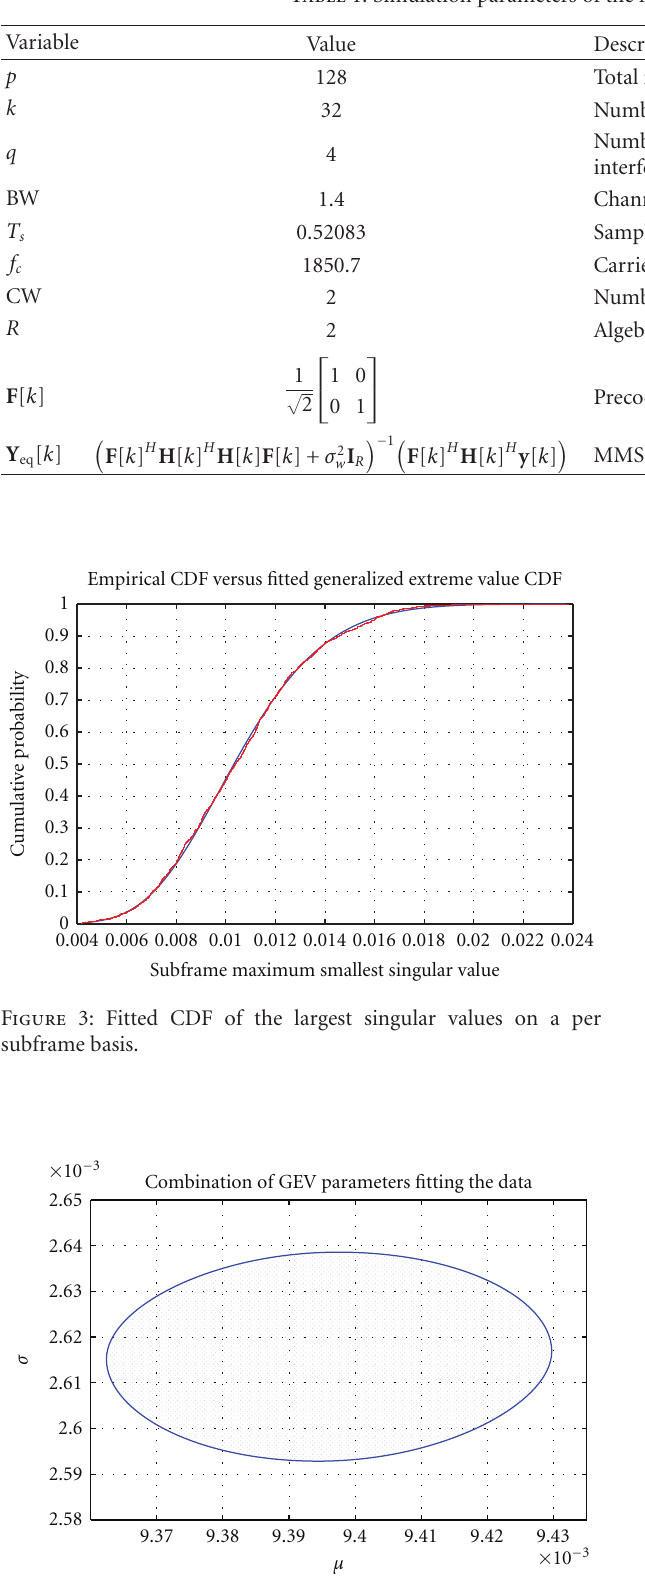
Table 1: Simulation parameters of the MIMO SC-FDMA (LTE-A Uplink).